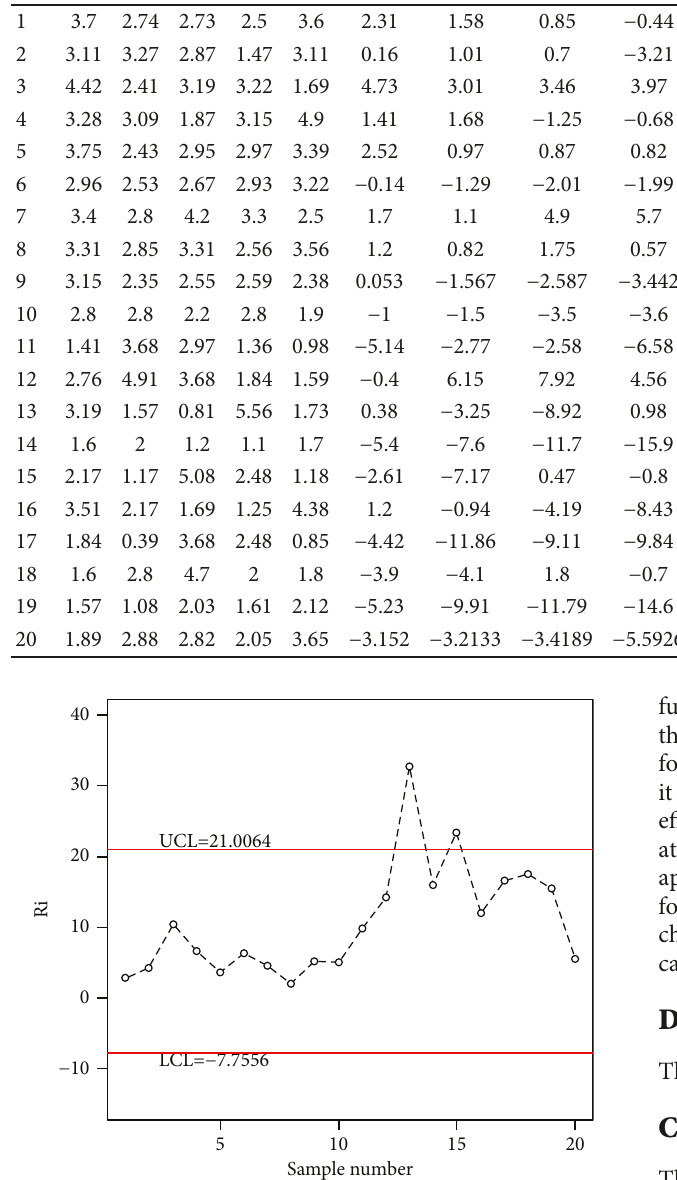
Figure 3: The proposed chart using the real